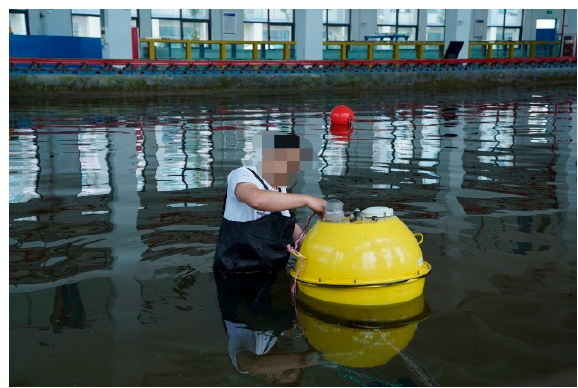
Figure 13. Wave pool experiment.